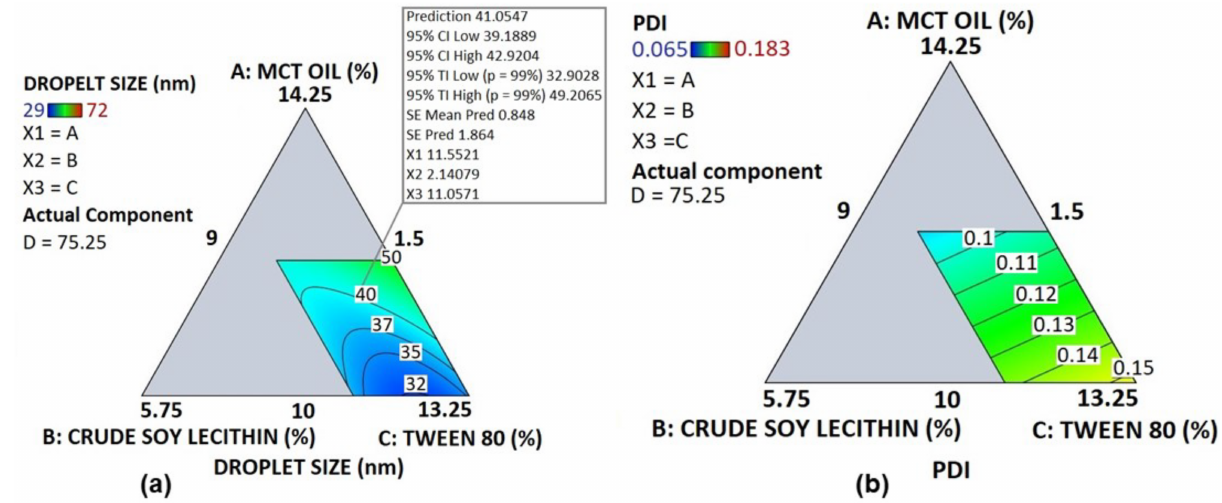
Figure 3. Contour plot of droplet size ( a ) and polydispersity index ( b